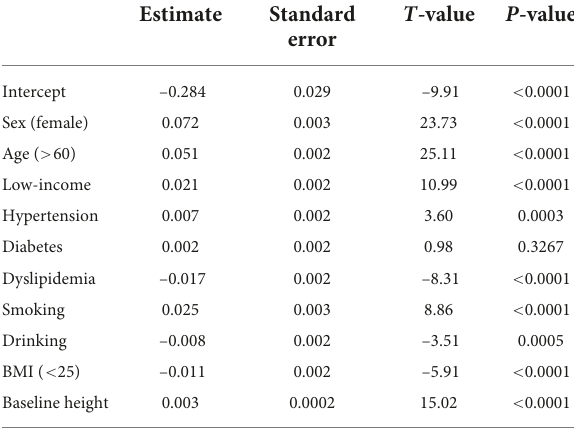
TABLE 8 Factors associated with affecting the annual height